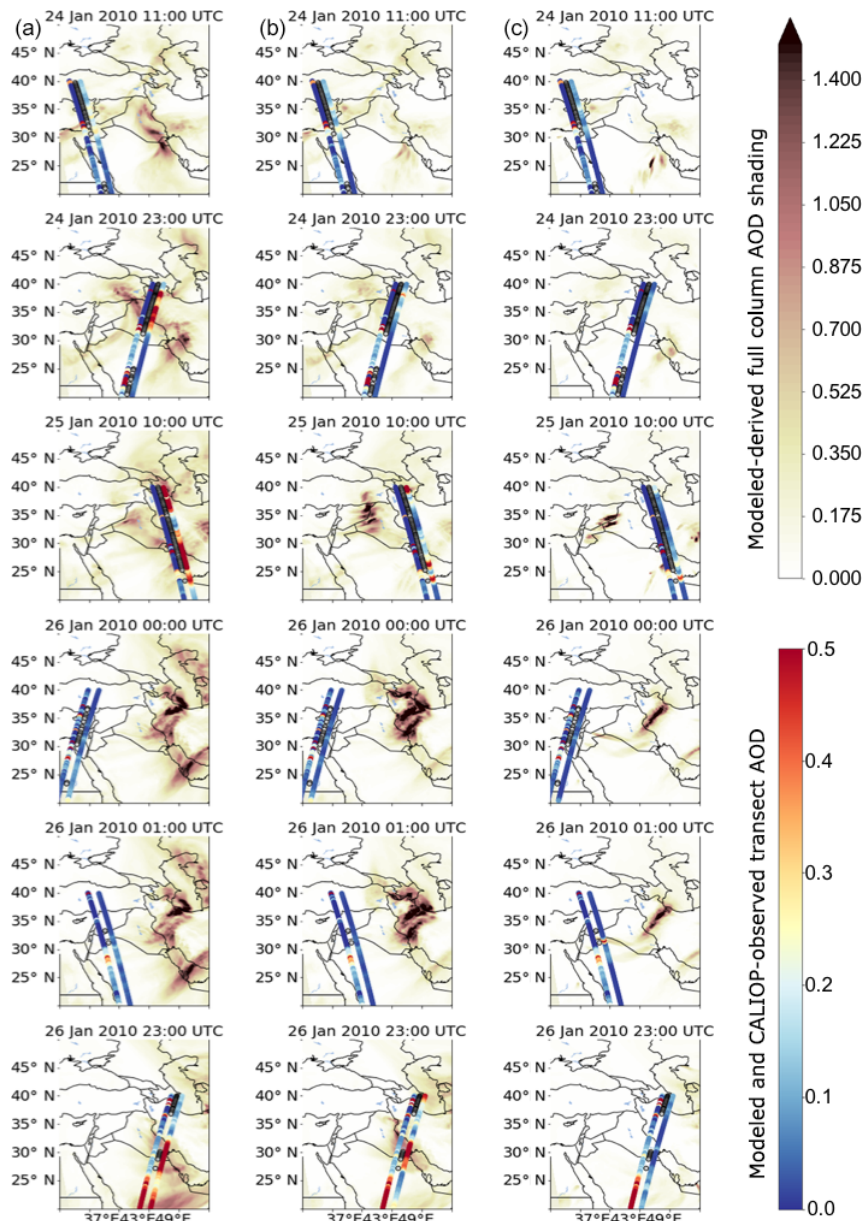
Figure 5. Shaded maps of modeled AOD for the GOCART-WRF (column a), AFWA (column b), and UoC (column c) schemes. Timestamps are indicated at the top of each image and are the same across the rows. Transects of AOD are also placed as overlays on each plot, with the three adjacent transects representing observed AOD from the CALIOP data (left transect line), locations along the transect where CALIOP observations are heavily impacted by cloud cover and retrieval does not represent full column AOD (center transect line), and modeled full-column AOD along the transect (right transect